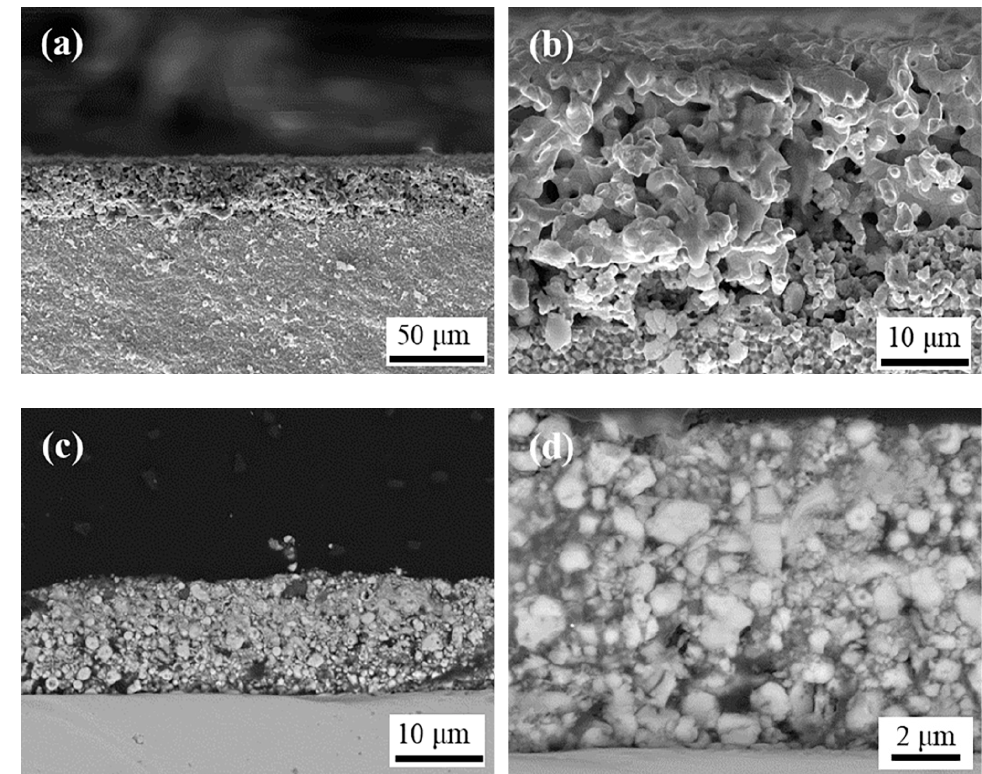
Figure 6. The cross-sectional morphology of the SPPS YSZ/LSM cathode after annealing treatment: ( a , b ) As-sprayed: ( a ) Low magnification. ( b ) High magnification. ( c , d ) Impregnating and polishing: ( c ) Low magnification. ( d ) High magnification .